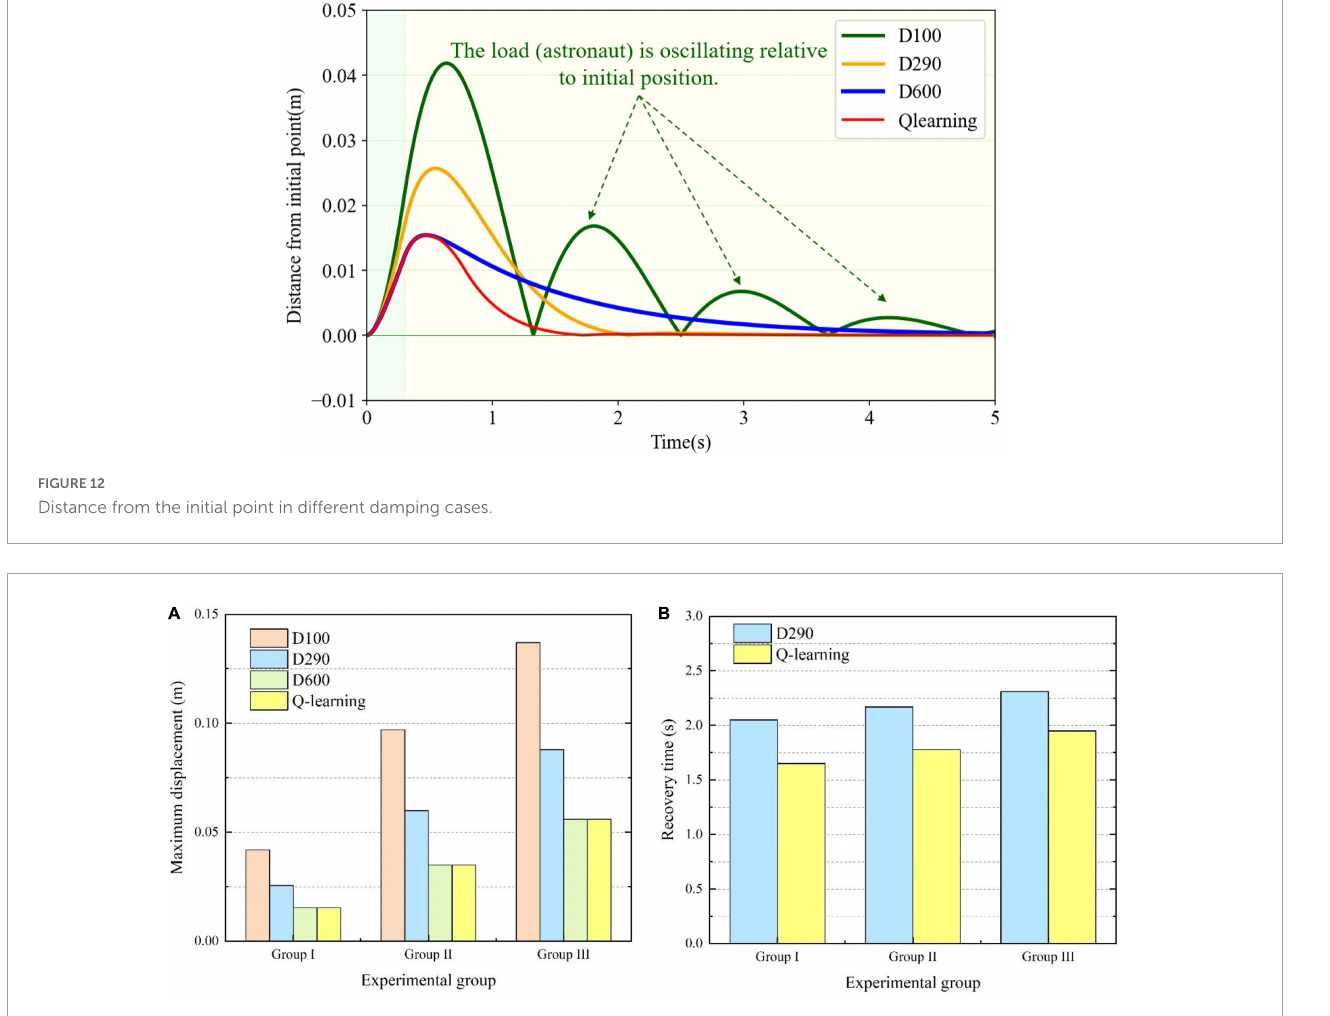
FIGURE13 Comparisons of maximum displacement and recovery time for different experimental groups. (A) Comparison of maximum displacement. (B) Comparison of recovery